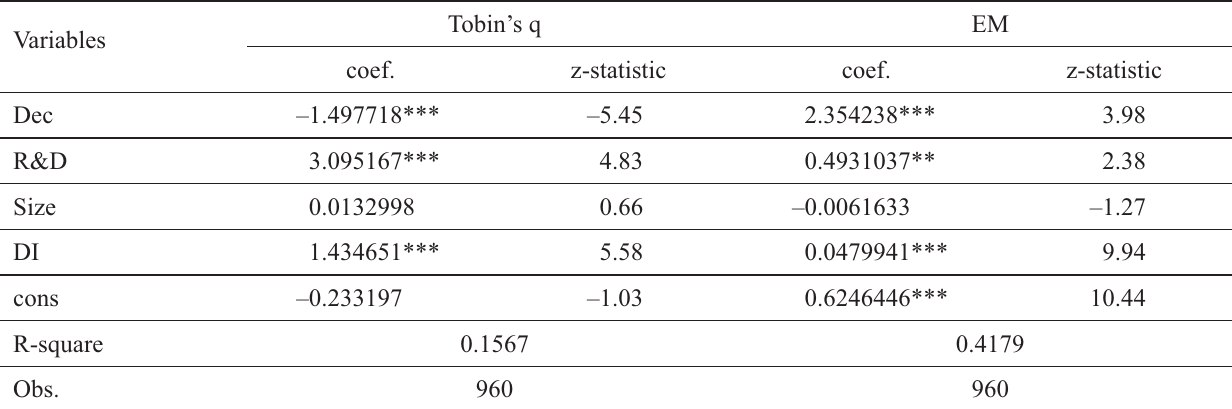
Table 2. The seemingly unrelated regression models